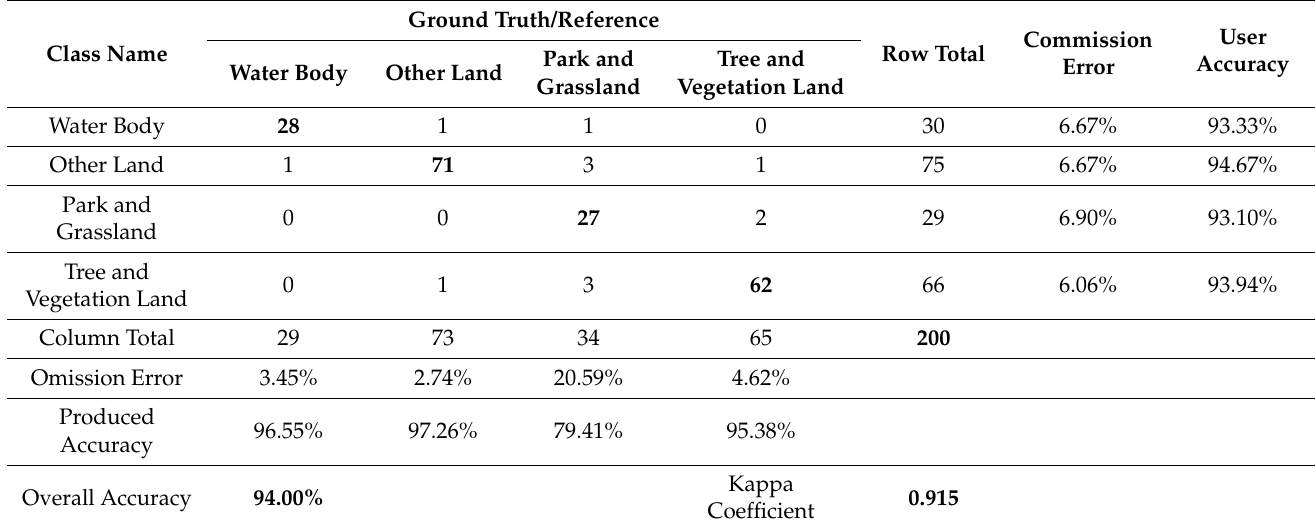
Table 5. Accuracy assessment and kappa coefficients for the year of 2010.